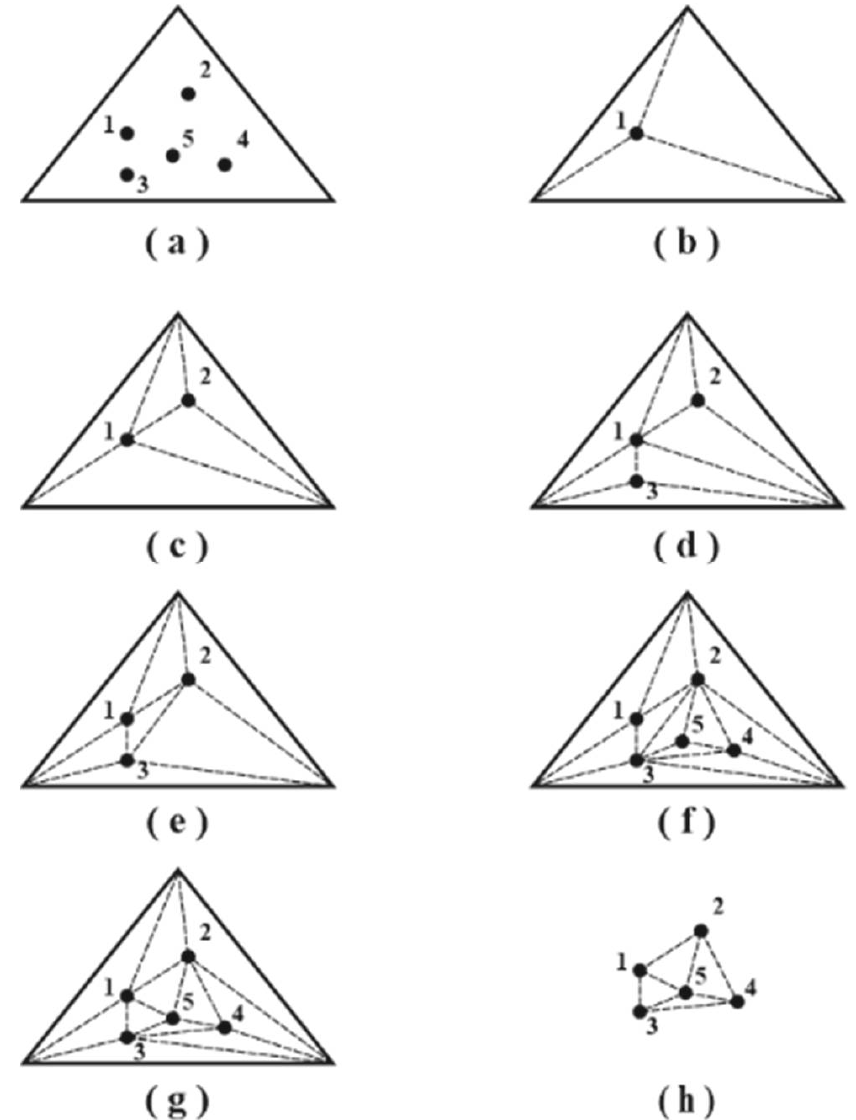
Figure 3. Gradual interpolation algorithm: Pre-construct a super triangle containing all points, sequentially select points from the given point data, and insert them into the super triangle to construct a triangular network according to certain rules until all points are inserted. Finally, delete the pre-constructed super triangle and its connecting lines, and the rest is the finally obtained TIN. ( a ) Point Group and Super Triangle. ( b ) Insert the First Point. ( c ) Insert the Second Point. ( d ) Insert the Third Point. ( e ) After Inserting the Third Point, Apply the Triangulation Modified by Lawson LOP Rule. ( f ) Insert the Fourth and Fifth Points. ( g ) After Inserting the Fifth Point, Apply the Tri-angulation Modified by Lawson LOP Rule. ( h ) Triangulation Net after Removing Super Triangle. Lawson’s LOP rule means that after inserting a point, the constructed triangulation must meet the maximum and minimum angle criterion of Delaunay triangulation. As shown in Figure 4, when the triangulation is reconstructed at the insertion point, if the triangulation does not meet the maximum–minimum angle criterion, the triangle must be corrected by exchanging diagonals (that is, local